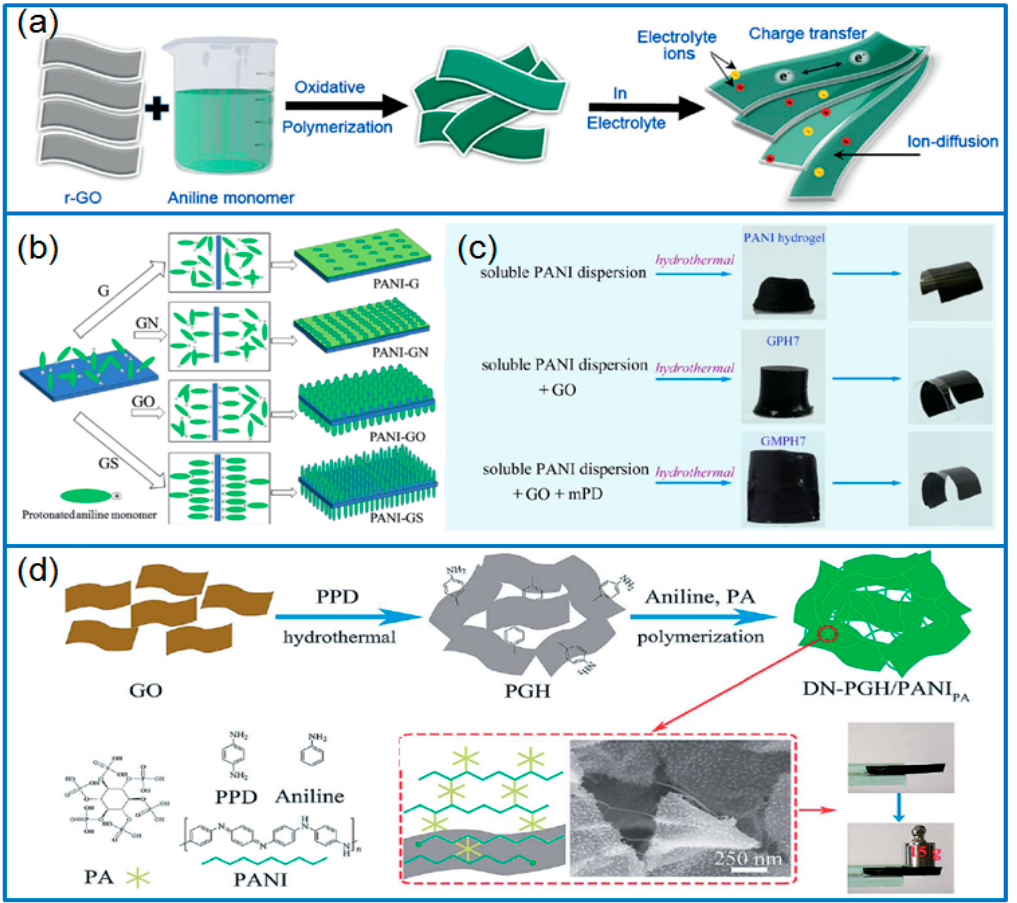
Figure3. ( a )SchematicforgrowingPANIonrGOflakes; producedwithpermission[39].